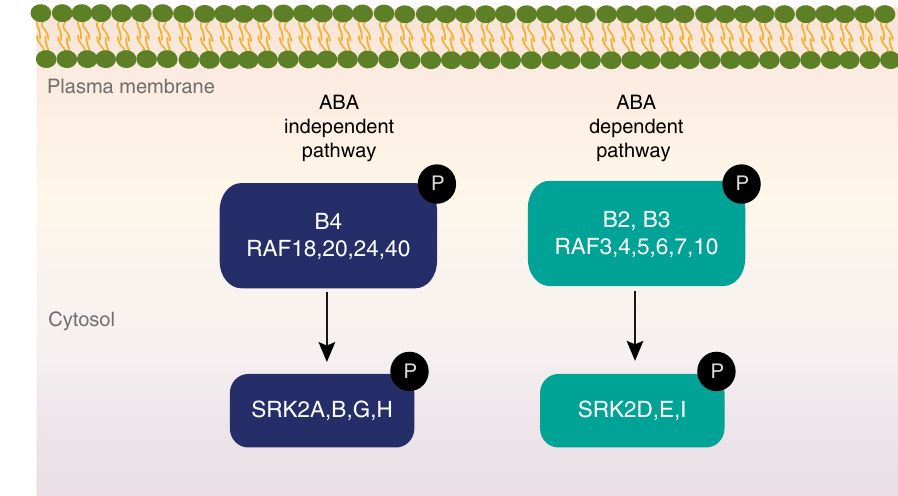
stress 51 – 54 . All four studies converge in a common fi nding: the Raf-like MAPKKKs are activated in response to osmotic stress and function upstream of the SnRK2 kinases in Arabidopsis , as previously reported in P. patens 50 . The B2/B3 family of Raf-like MAPKKKs regulate the ABA signalling pathway by phosphor- ylation of the ABA-responsive SnRK2s from subclass III, consistent with the fi ndings in P. patens (Fig. 2). By contrast,